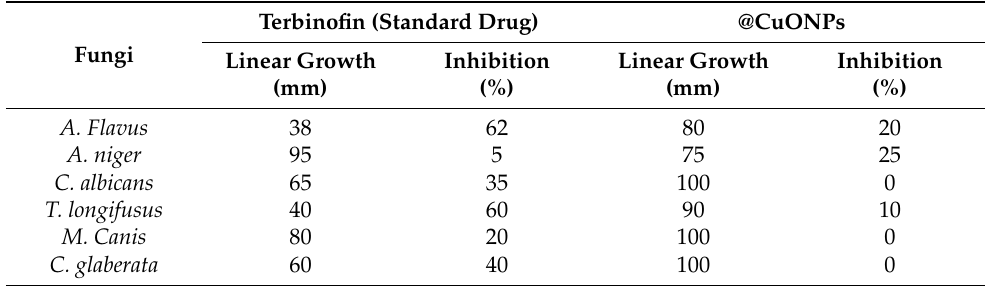
Table 2. Anti-fungal activity of CuO